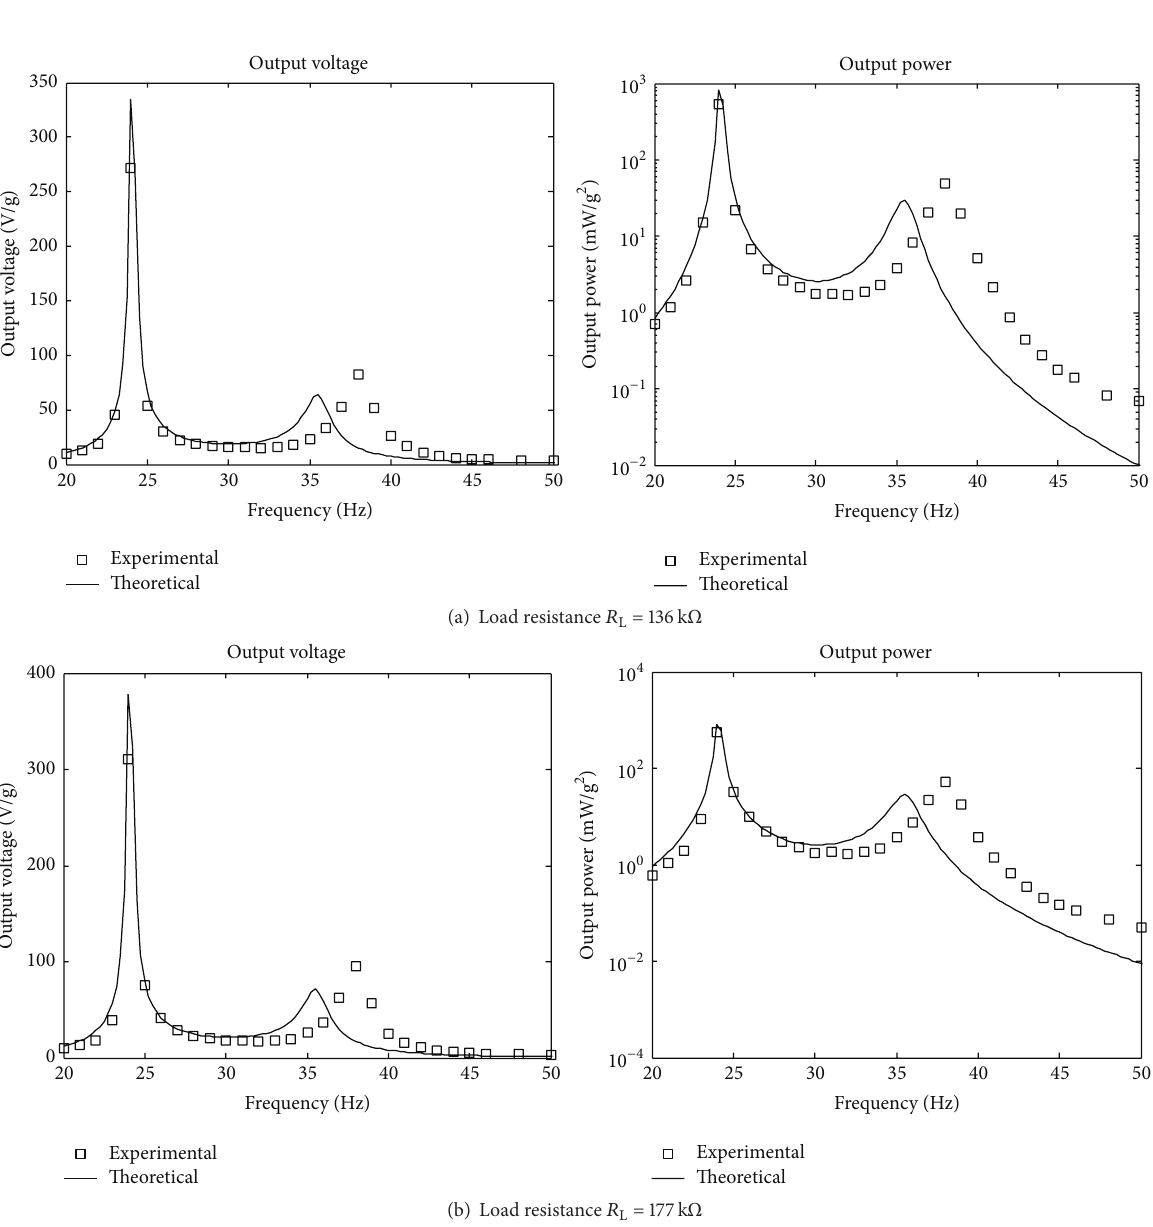
Concerning the vision of the proposed BPEH, when the mass ratio 𝑎 is larger than the critical mass ratio 𝑎 𝑐 , the electrical output of the BPEH is larger than that of the CPEH over a frequency range between 𝑓 r and 𝑓 ar . However, from a practical viewpoint, the realization of a large mass ratio within the limited space of a BPEH will be